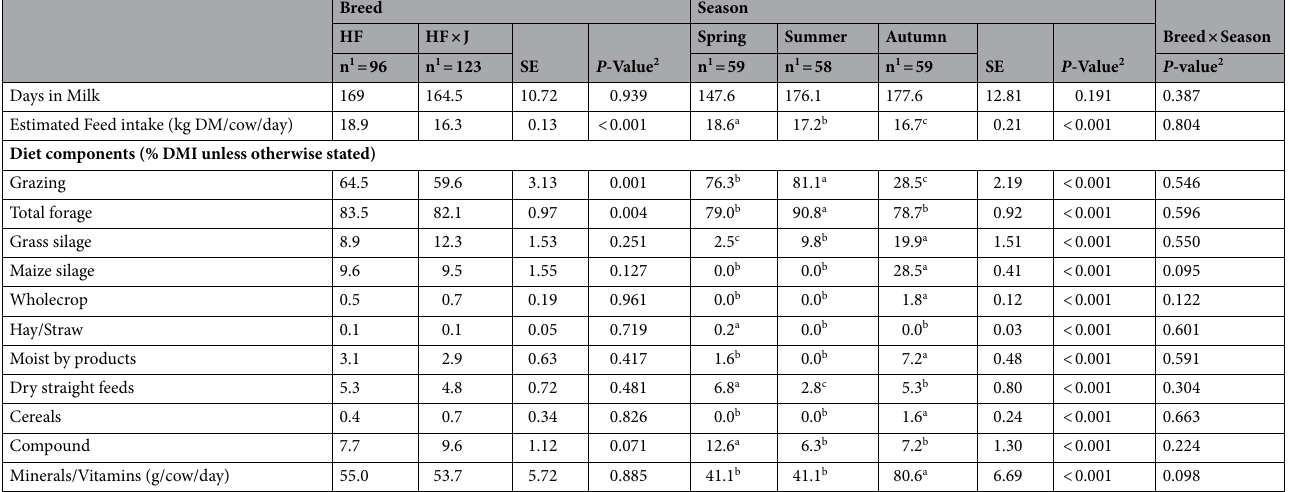
assessed as total across the year (cases of mastitis, lameness and other health; number of fertility treatments and services), were investigated using a generalised linear mixed model in Genstat® 18 35 using breed as fixed factor and Farm ID as random factor. When the fixed effect was significant ( p < 0.05), pairwise comparisons of means were performed using Fisher’s Least Significant Difference test. Normality of the residuals were visually assessed and most showed no deviation from normality, except for fat non-grazing efficiency, somatic cell count, mastitis cases, all health cases, other health cases and services, which were log transformed prior to REML analysis. Descriptive statistics to generate means and standard errors for presentation in tables, were carried out in Minitab® 20.2. Multivariate redundancy analysis (RDA) was carried out using Canoco5® 36 to further investigate the impact of breed and diet on productivity, milk basic composition and efficiency parameters, FA profiles and health and fertility parameters. In the RDA biplots for productivity, basic composition, and efficiency parameters, and FA profiles, arrow length and direction represent the relative effects of driver variables (breed and diet composition parameters) on the response variables (productivity, basic composition, efficiency parameters, FA profiles). The driver related to breed represents the contribution of Jersey genetics to the genome. Drivers related to nutrition were dietary proportions of estimated grazing (GRA), total forage (TF), grass silage (GS), Maize silage (MS), wholecrop silage (WC), hay/straw (HS), moist by-products (MBP), dry straights (DRY), cereals (CER), com- pound (COM) and minerals and vitamins (MIN). The response variables in Fig. 1 included milk yields of fat and protein; fat:protein ratio; milk contents of fat content, protein, lactose, and urea; SCC; efficiency parameters (feed, non-grazing, concentrate, fat, fat non-grazing, fat concentrate, protein, protein non-grazing, protein concentrate). The response variables in Fig. 2 included milk FA profile (butyric acid, C4:0; caproic acid, C6:0; caprylic acid, C8:0; capric acid, C10:0; lauric acid, C12:0; myristic acid, C14:0; palmitic acid, C16:0; stearic acid, C18:0; vaccenic acid, VA; oleic acid, OA; linoleic acid, LA; rumenic acid, RA; α-linolenic acid, ALNA; eicosapentaenoic acid, EPA; docosapentaenoic acid, DPA; docosahexaenoic acid, DHA; saturated FA, SFA; monounsaturated FA, MUFA; cis- monounsaturated FA, cMUFA; polyunsaturated FA, PUFA; cis -polyunsaturated FA, cPUFA; omega-3 poly- unsaturated FA, n-3; omega-6 polyunsaturated FA, n-6; n-3:n-6 ratio; n-6:n-3 ratio; trans FA; trans FA excluding VA; Atherogenicity index, AI; Thrombogenicity index, TI; Hypocholesterolemic to Hypercholesterolemic ratio, HH). In the RDA biplot for health and fertility parameters (Fig. 3), the arrow length and direction represent the relative effects of driver variables (breed and diet composition parameters) on the response variables (health and fertility). The driver related to breed represents the contribution of Jersey genetics to the pedigree. Drivers related to nutrition were dietary proportions of estimated grazing, GRA; silages (grass silage, maize silage and whole crop silage), SIL; hay/straw, HS; concentrates (moist by-products, cereals, compound feed and dry straights), CON; minerals, MIN. The response variables included total incidences of mastitis, lameness, other health cases and all health cases, and fertility, calving interval, services, and calving interval:service ratio. Ethical approval.